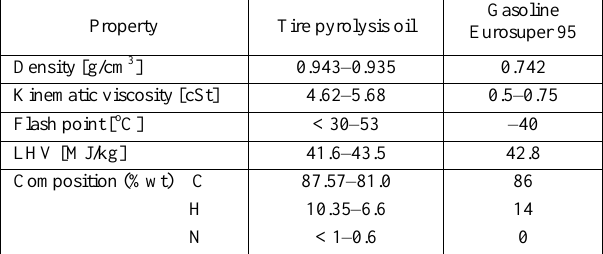
Table 1. Comparison of the properties of tire pyrolysis oil and gasoline